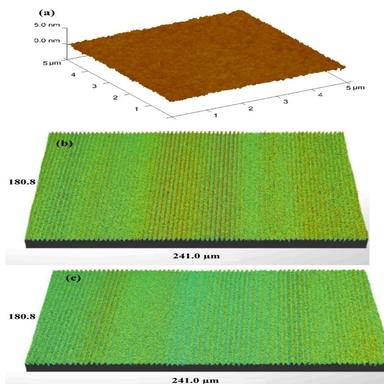
3D-AFM and interferometric microscopy images of the surfaces after CMP with (a, b) D-mSiO2-75 and (c) D-mSiO2-90.